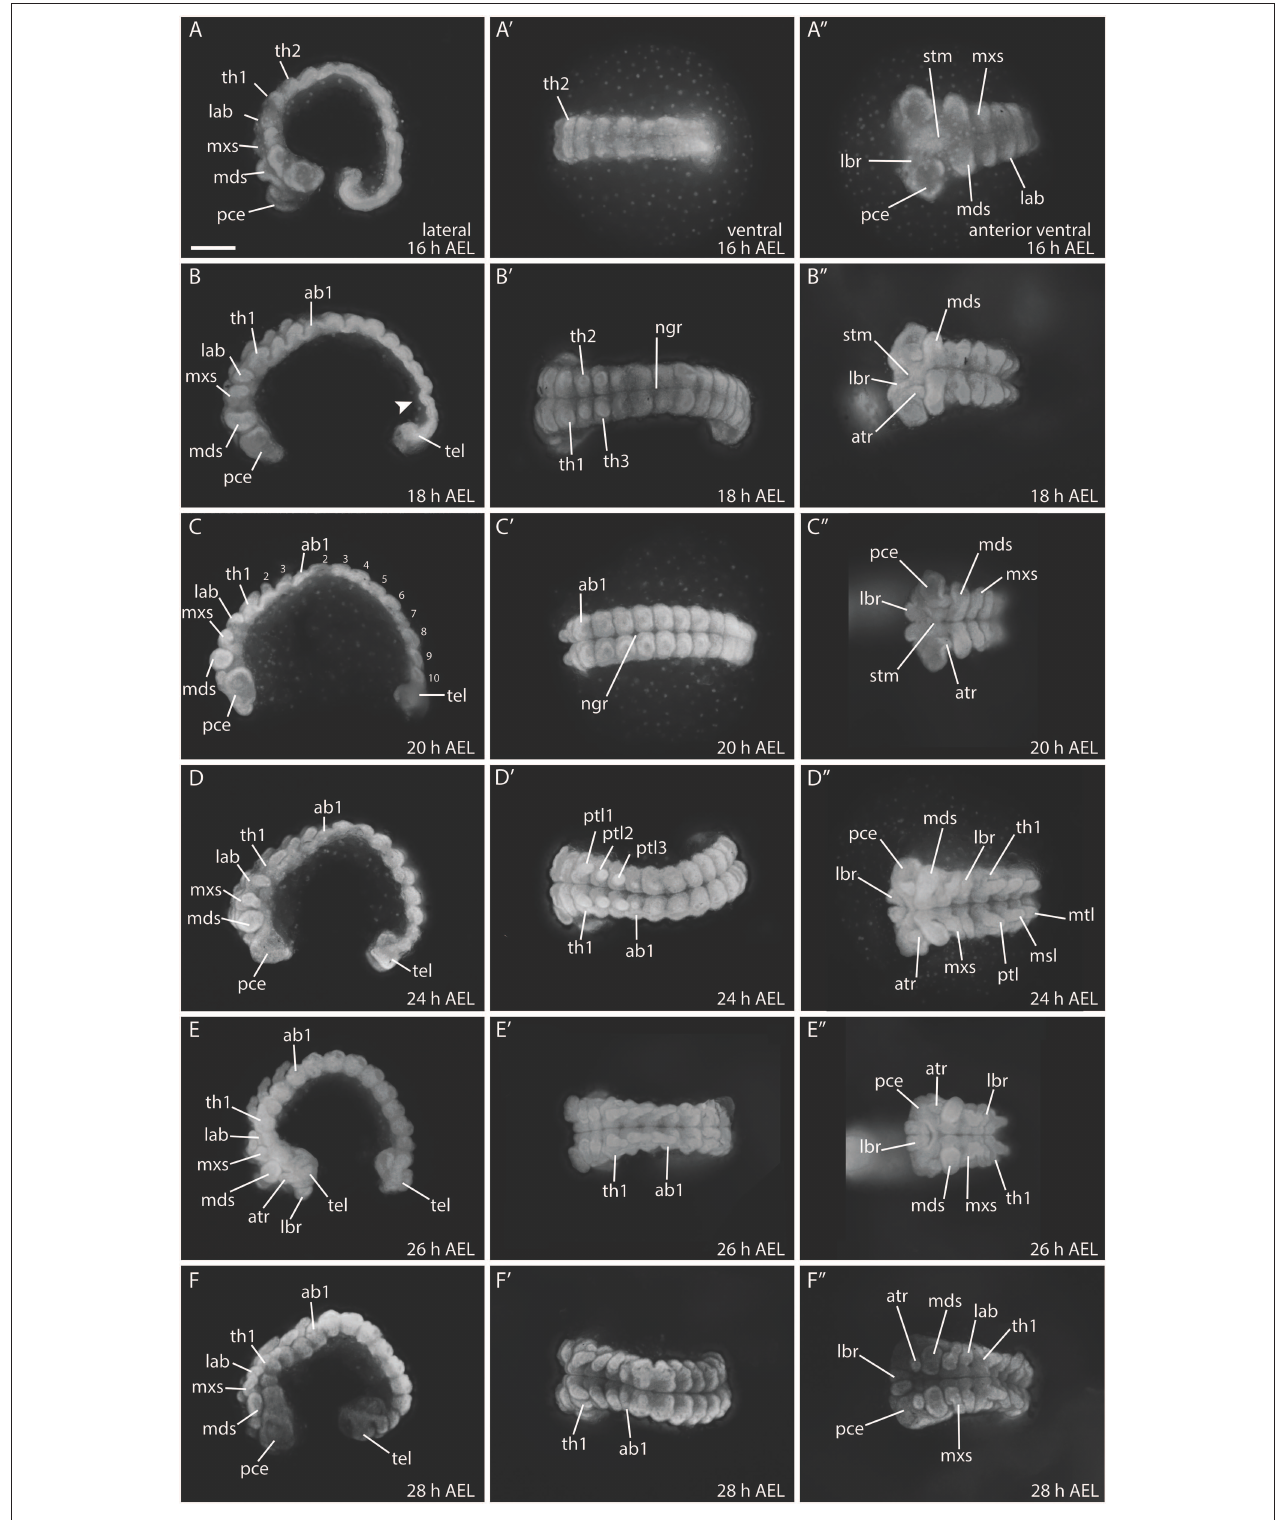
FIGURE 6 | Embryonic development from 16 to 28 hours in B. anynana. (A–F ′′ ) See detailed description in text. ab1, abdominal segment 1; AEL, after egg laying; atr, antennal rudiment; lab, labial segment; lbr, labrum; mds, mandibular segment; mxs, maxillary segment; pce, protocephalon; pco, protocorm; ptl, prothoracic leg 1-3; stm, stomodeum; tel, telson; th1, thoracic segment. All columns are orientated in the same way as indicated in the top row. Anterior is always to the left and the ventral side is to the top. All pictures are to the same scale. Scale bar: 400 µ m.